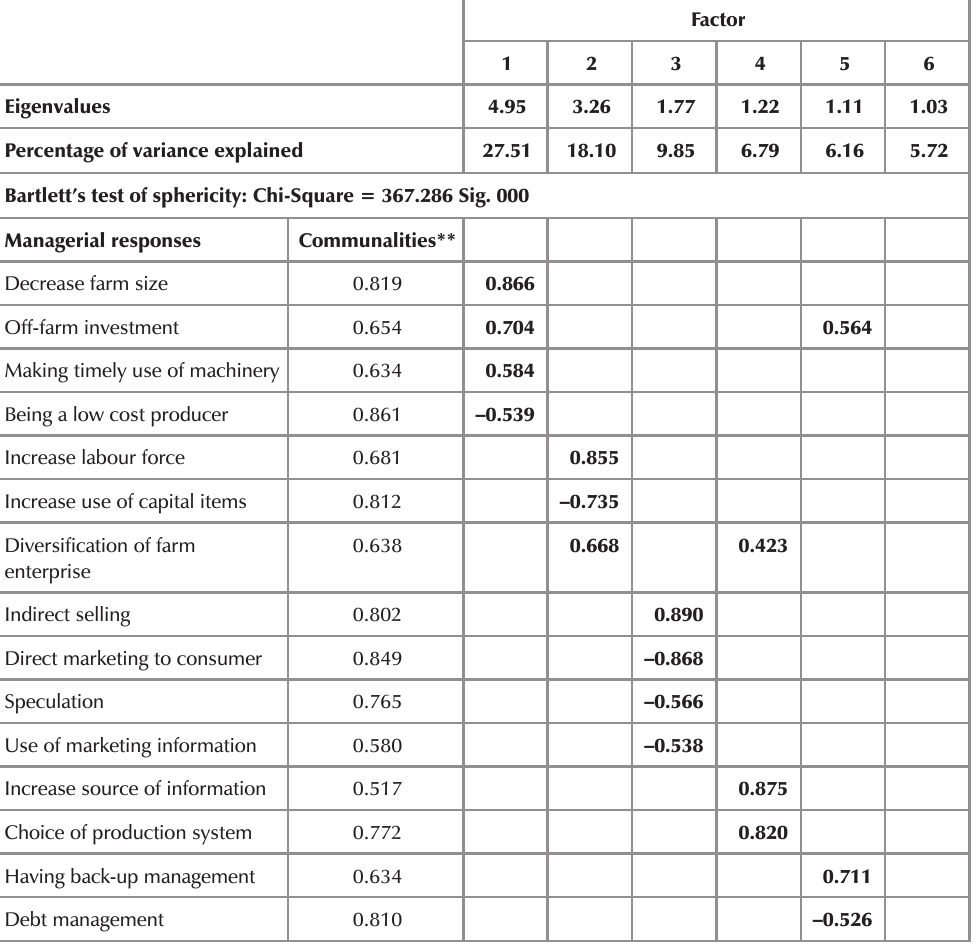
Rotated factor loadings* and factor scores of managerial responses to risk for sample commercial crop farmers in the three zobatat of Eritrea, 2002/03 (n=